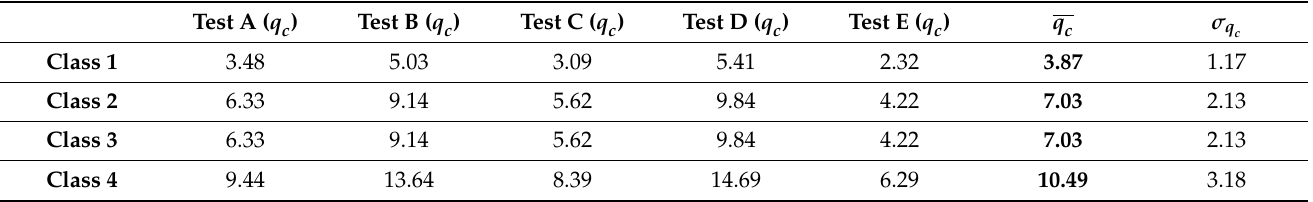
Table 4. Critical discharge values (m 3 .s − 1 ) per meter, from each individual test corresponding to the four consequence class dams using Froude scaling law, with associated mean and standard deviation values.